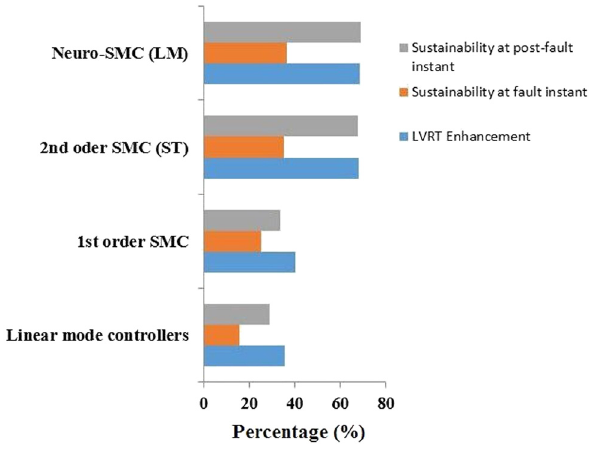
Figure 17: Comparative study of e ffi cient